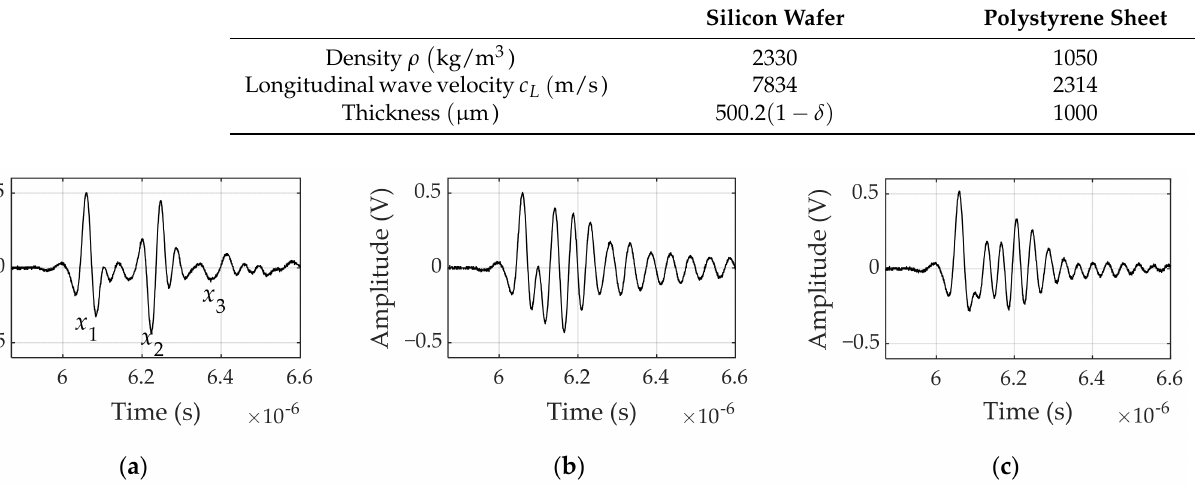
Figure 12. AMI signals with different degrees of overlap: ( a ) δ = − 30%; ( b ) δ = 50%; ( c ) δ = 60%.